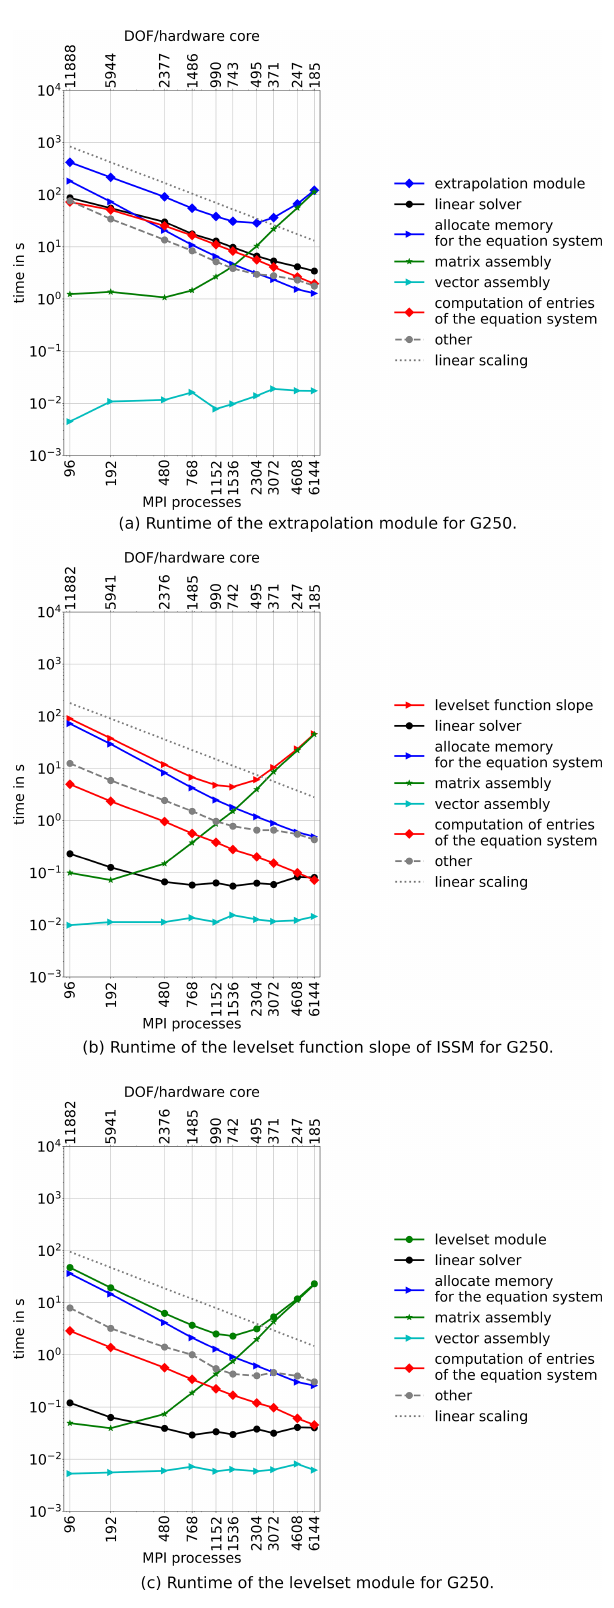
Figure 6. Runtime of the moving front module for G250.